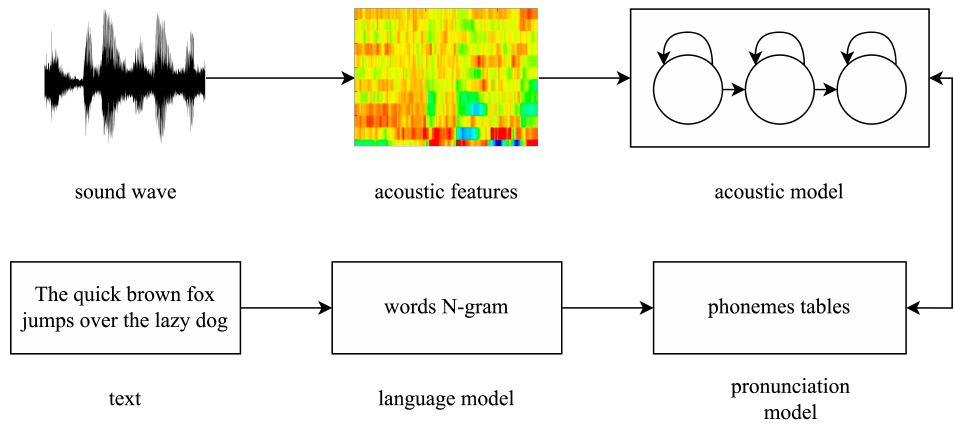
Figure 2. Architecture of Hidden Markov Model-based Automatic Speech Recognition